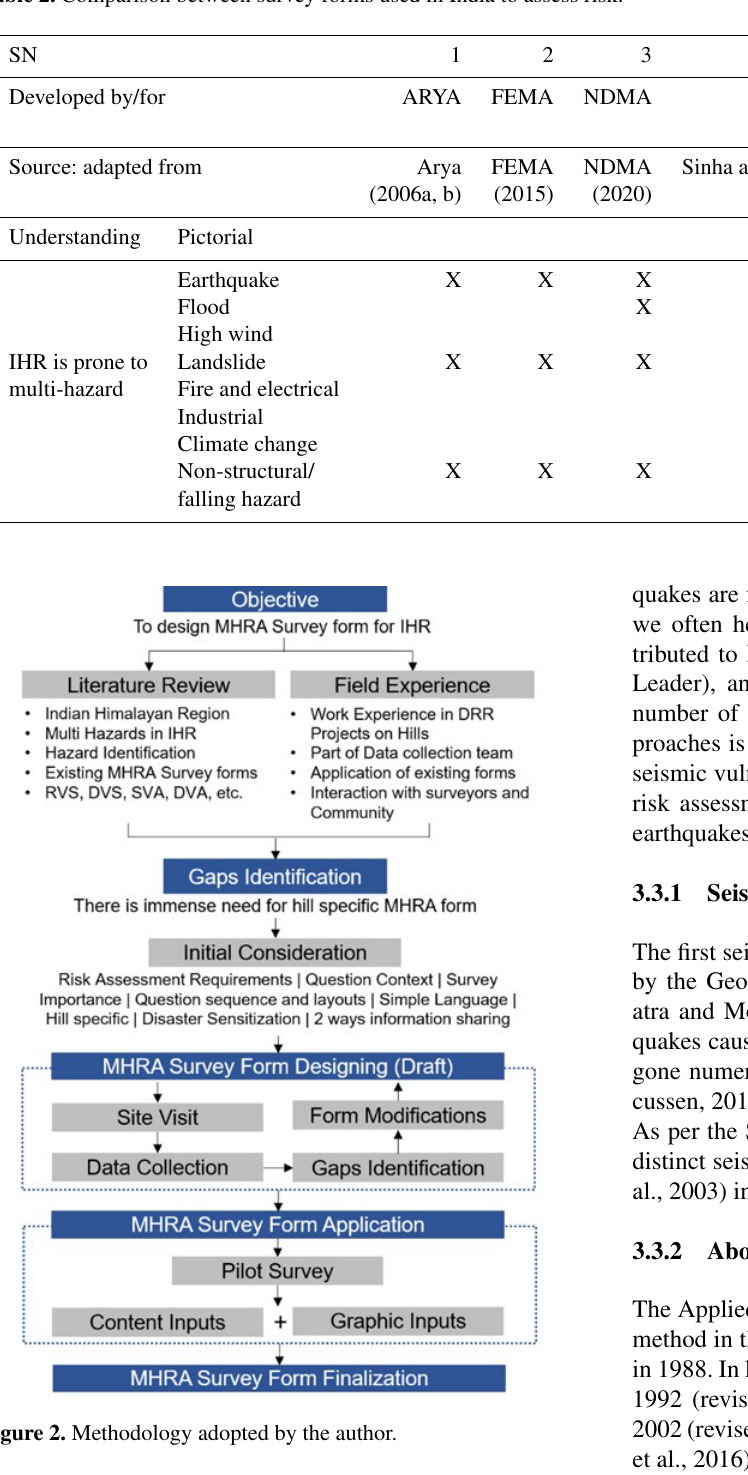
mental activities, as well as a lack of awareness,